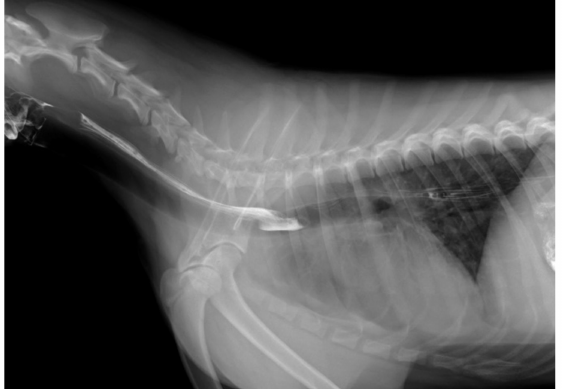
Figure 1. Pre-operative right lateral barium contrast study of the esophageal radiograph. The X-ray image revealed persistence of the contrast medium and mild esophageal dilatation at the level of the third intercostal